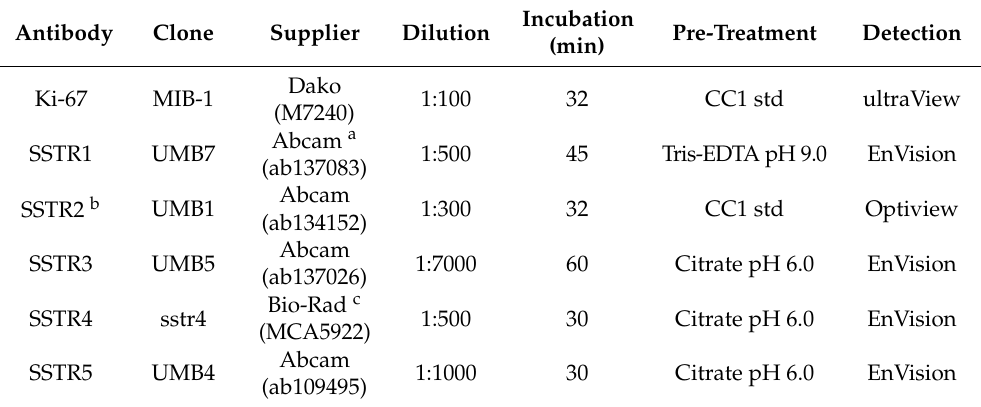
Table 3. Somatostatin receptor (SSTR) and Ki-67 antibodies and staining protocols used for